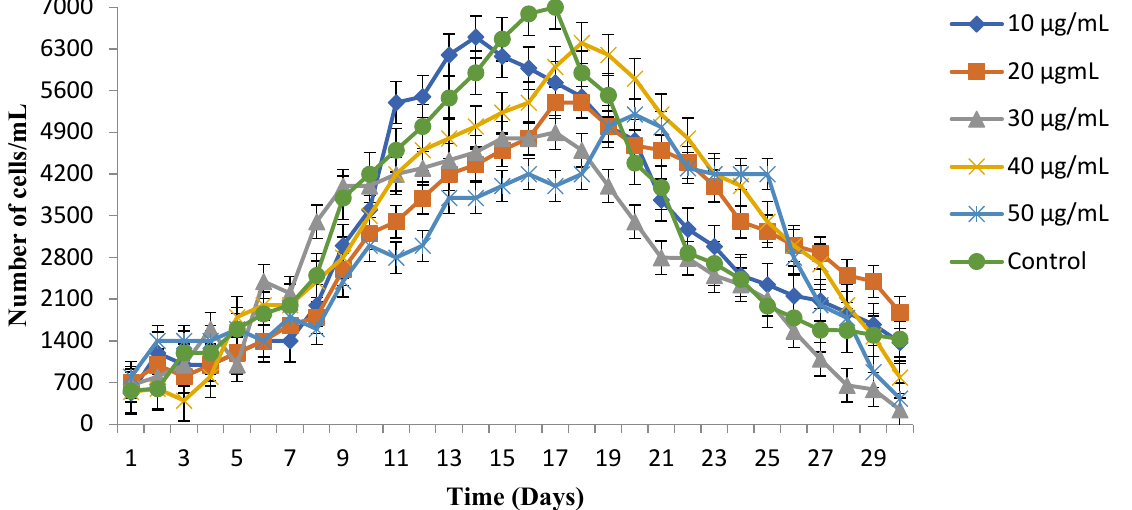
Figure 1. Growth curves of Paramecium multimicronucleatum under different concentrations of copper along with control .